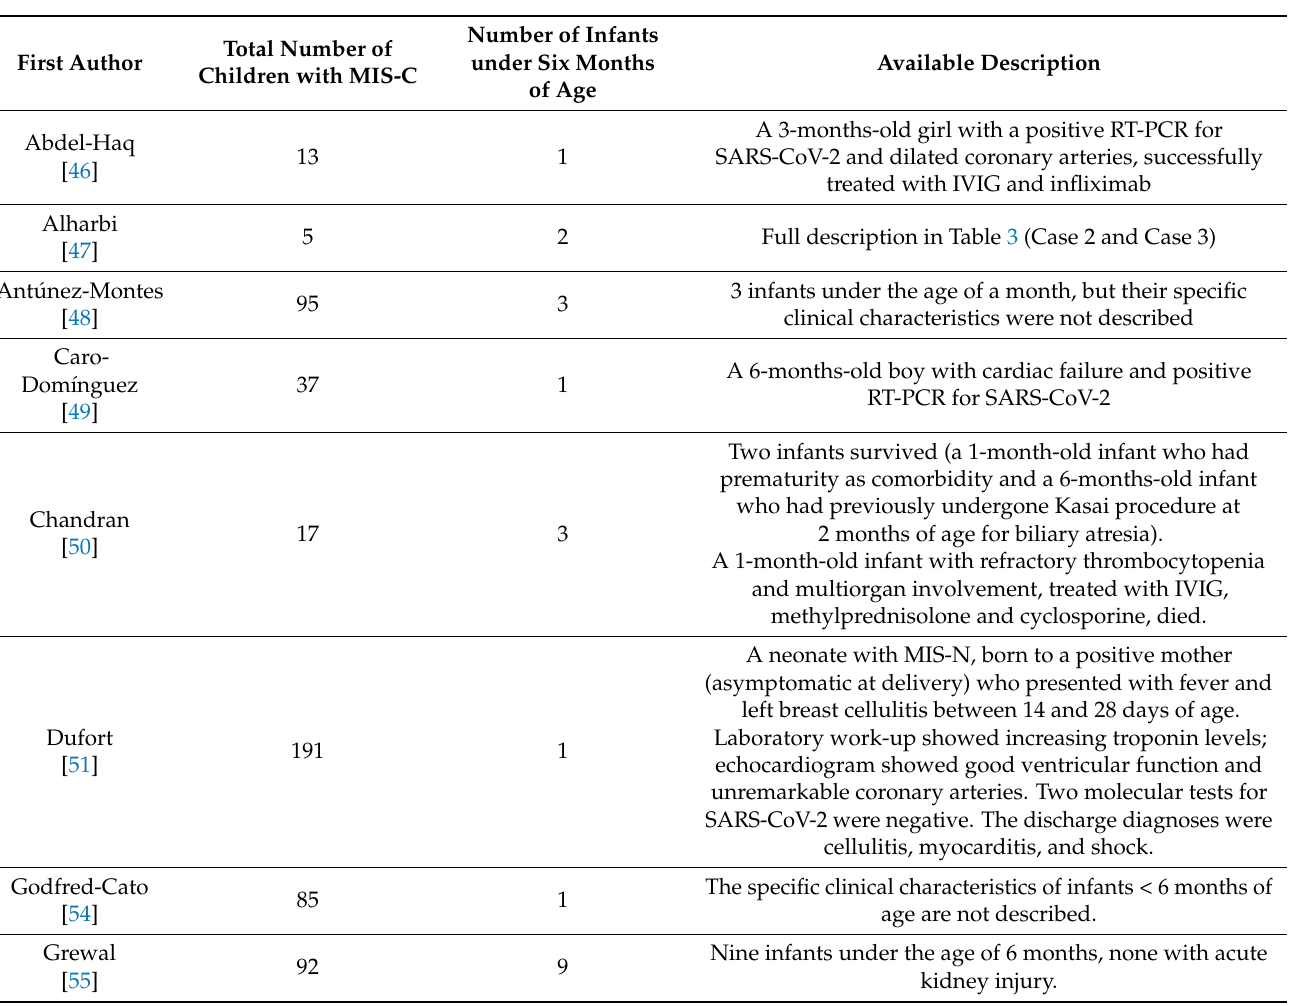
Table 4. Characteristics of infants with MIS-N and MIS-C belonging to cohort studies and not fully